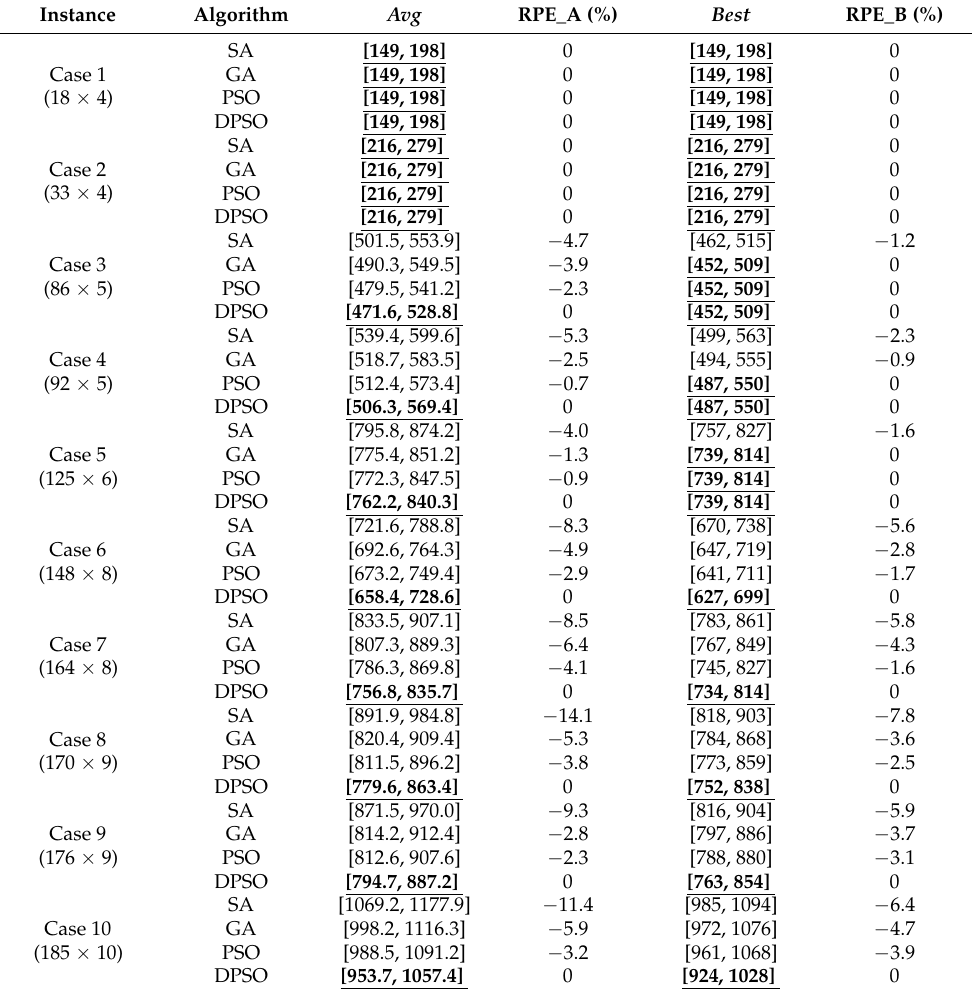
Table 5. Comparisons of SA-MAE and the four existing algorithms for the AJSSP on different